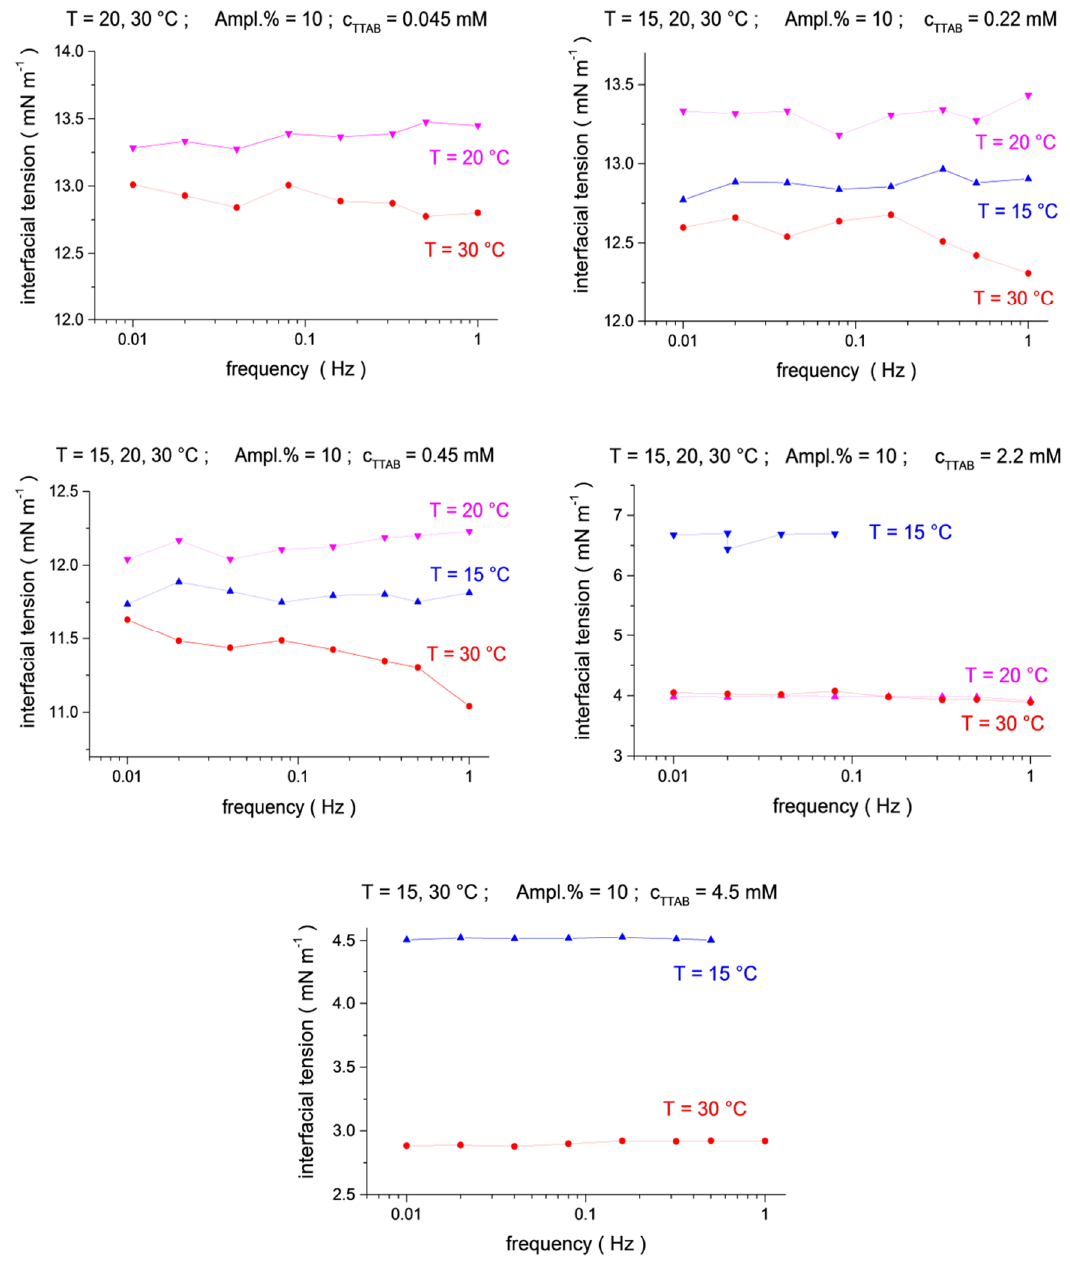
Figure 2. Temperature dependence (blue up triangles T = 15 °C, magenta down triangles T = 20 °C, red circles T = 30 °C) for the mean-level values of interfacial tension oscillations as a function of frequency (f = 0.01, 0.02, 0.04, 0.08, 0.16, 0.32, 0.5 and 1.0 Hz) at TTAB concentrations of c 2 = 4.5 × 10 −5 , 2.2 × 10 −4 , 4.5 × 10 −4 , 2.2 × 10 −3 and 4.5 × 10 −3 mol/dm 3 , at a fixed C 13 DMPO concentration of c 1 = 2.2 × 10 −5 mol/dm 3 .